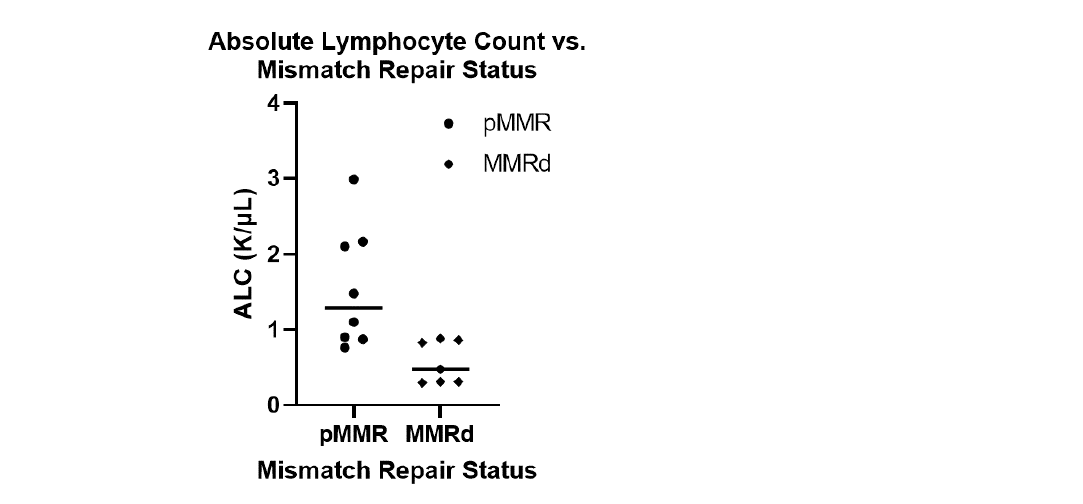
Figure 2. Comparing the absolute lymphocyte count between mismatch proficient and deficient colorectal cancer in transplant population. A total of 15 patients within our cohort had absolute lymphocyte counts (ALC) carried out at the time of their diagnosis along with mismatch repair status determination and tumor mutation burden. Of these, 8 patients were mismatch repair proficient (pMMR) and the other 7 patients were mismatch repair deficient (MMRd). The pMMR tumors had a higher ALC (median: 1.20, mean: 1.55) then the MMRd tumors (median: 0.48, mean: 0.57) which was statistically significant (student’s t-test: p -value = 0.009).